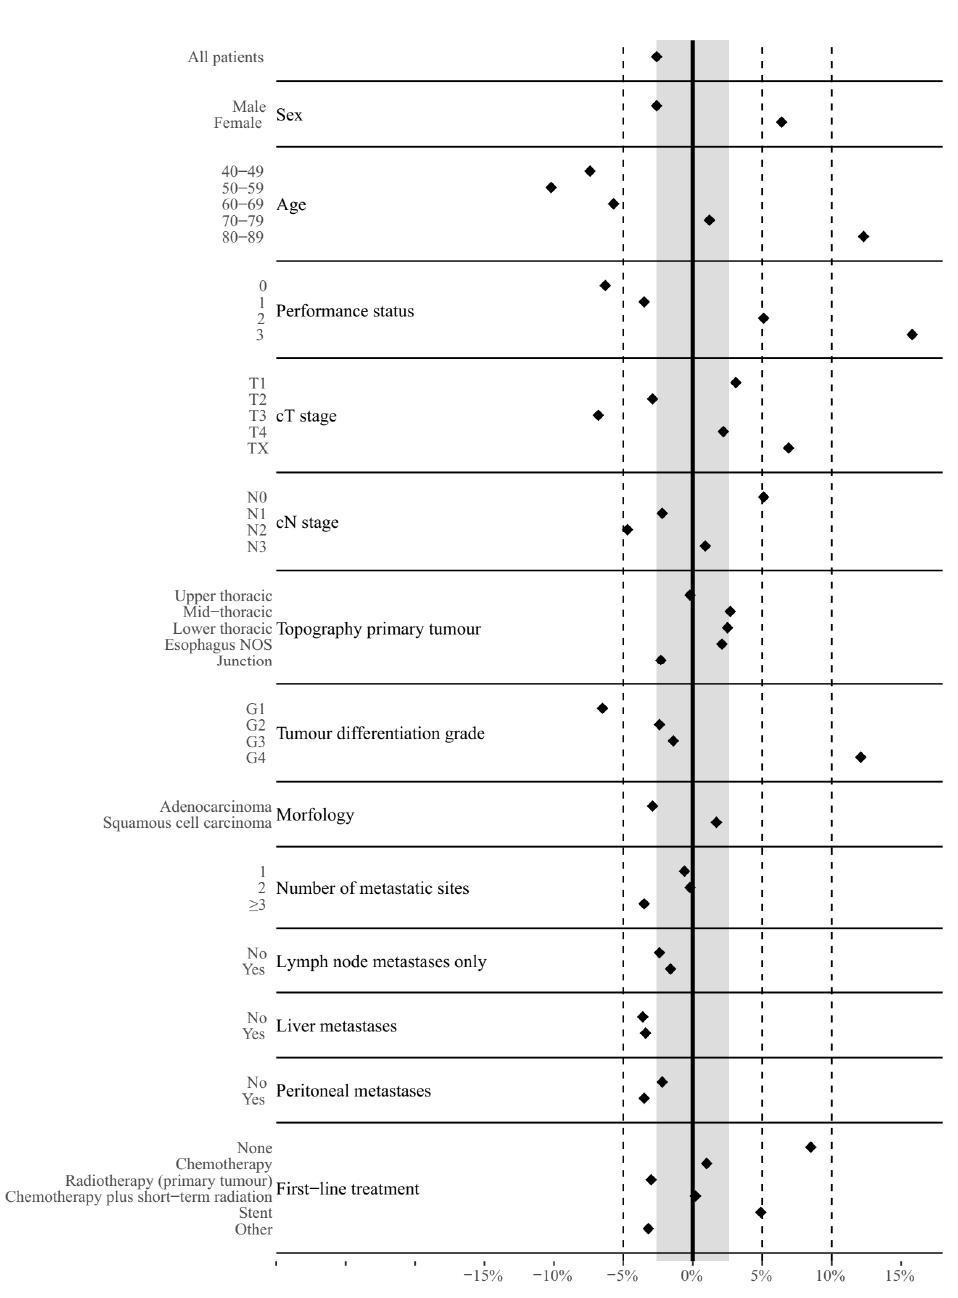
Figure 3. Mean differences between predicted and observed six-month overall survival for Figure 3. Mean di ff erences between predicted and observed six-month overall survival for oesophageal oesophageal cancer patients by patient subgroups. Values >0% indicate an overestimation and values cancer patients by patient subgroups. Values > 0% indicate an overestimation and values < 0% indicate <0% indicate an underestimation in overall survival. The grey band represents the mean difference an underestimation in overall survival. The grey band represents the mean di ff erence between predicted between predicted and observed six-month overall survival for the entire oesophageal cancer cohort. and observed six-month overall survival for the entire oesophageal cancer